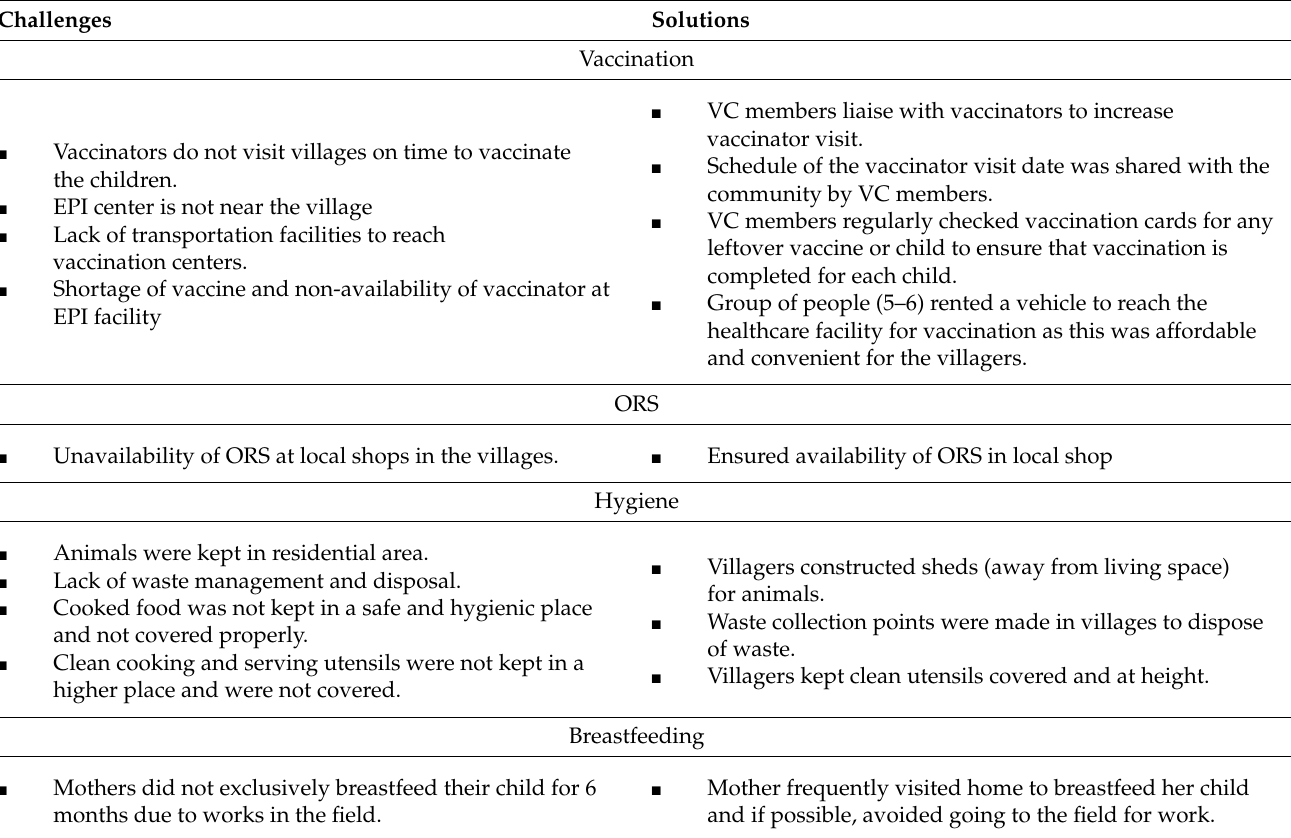
Table 2. Local challenges and contextualized